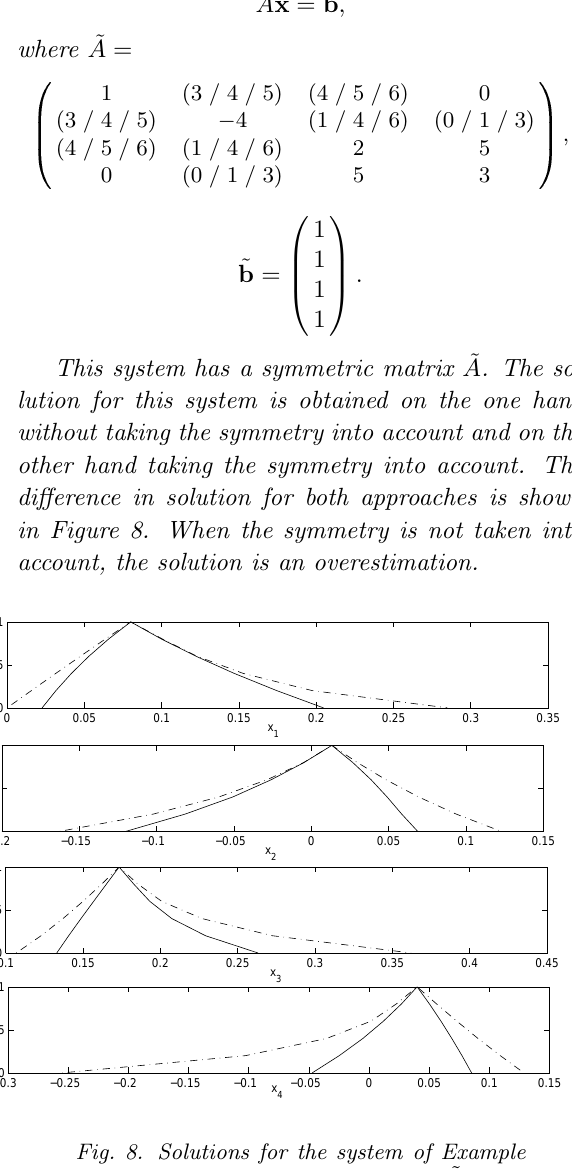
Fig. 8. Solutions for the system of Example 4 with the symmetry of the matrix ˜ A taken into account (full line) and without taking the symmetry into account (interrupted